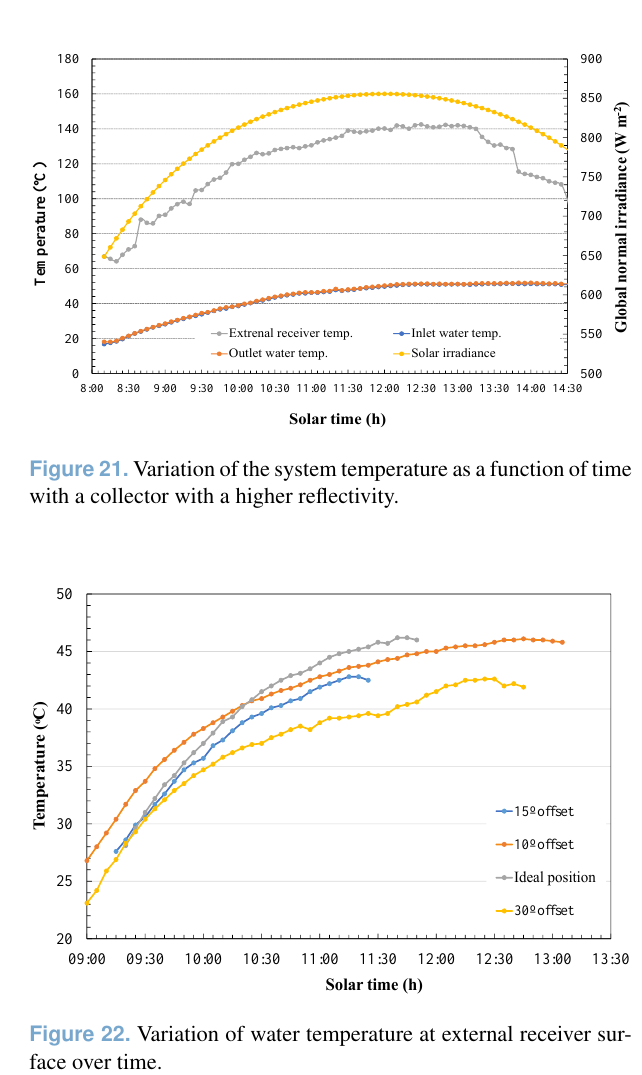
Figure 20. Variation of the system temperature as a function of time with a collector with a lower reflectivity.